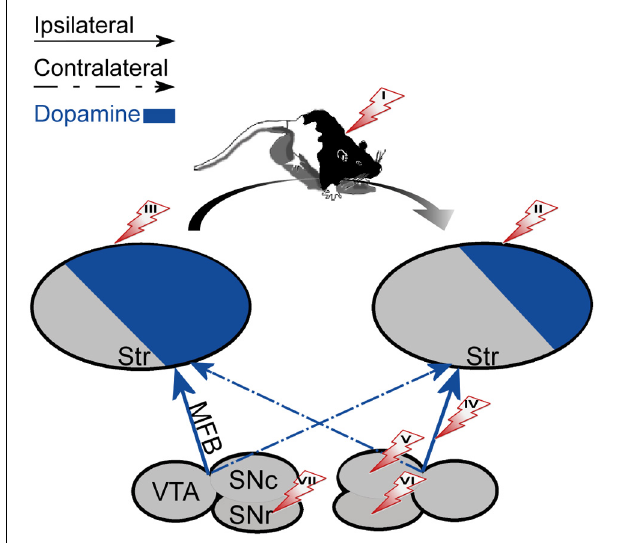
FIGURE 2 | The effect of unilateral biochemical manipulations. The specified manipulations were placed on the side that induced rotation in the right direction (marked with an arrow). The direction of rotation was always contralateral to the striatum with a high DA concentration (left). (I) systemic administration of d-amphetamine (enhances natural asymmetry). (II) 6-OHDA lesion of the striatum. (III) DA agonists, Acetylcholine antagonists or NMDA administered to the striatum. (IV) 6-OHDA lesion of the MFB. (V) 6-OHDA lesion or DA administration to the SNc. (VI) GABA antagonists administered to the SNr. (VII) DA agonists, Acetylcholine agonists or GABA agonists administered to the